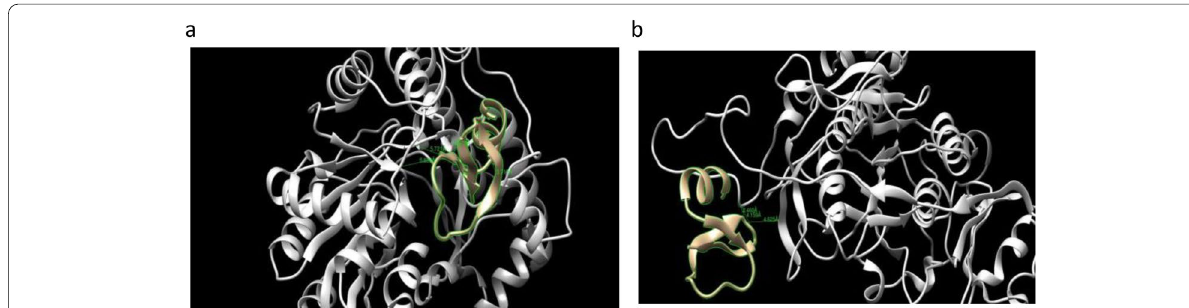
Fig. 10 Docking results of β-defensin 1 against a cystalysin and b dentilisin of T. denticola